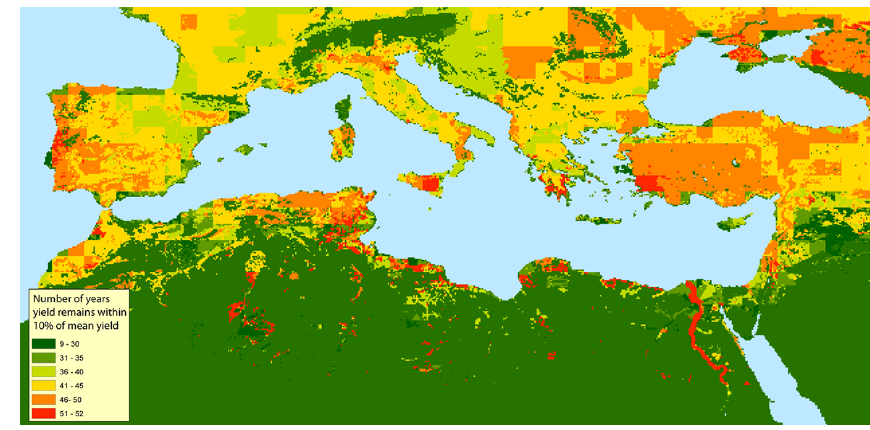
Figure 7. The stability of yields over time. The map shows in how many years the total annual yield in each cell remains within 10% of the average yield for the same cell calculated over 52 years of climate forcing. In the Nile Valley, yields remain within 10% of the average yield in all years, meaning that yields are exceptionally stable. Regions of northern Spain and northern France are relatively unstable with yields dropping below 10% in at least 40 out of 52